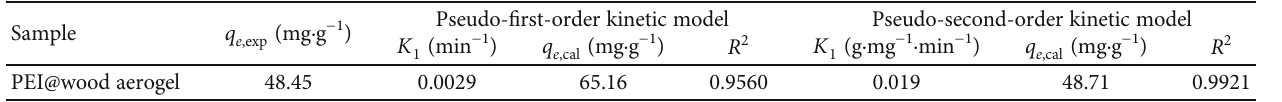
Table 2: Kinetic parameters for the adsorption of Cu(II) by PEI@wood aerogel. Sample